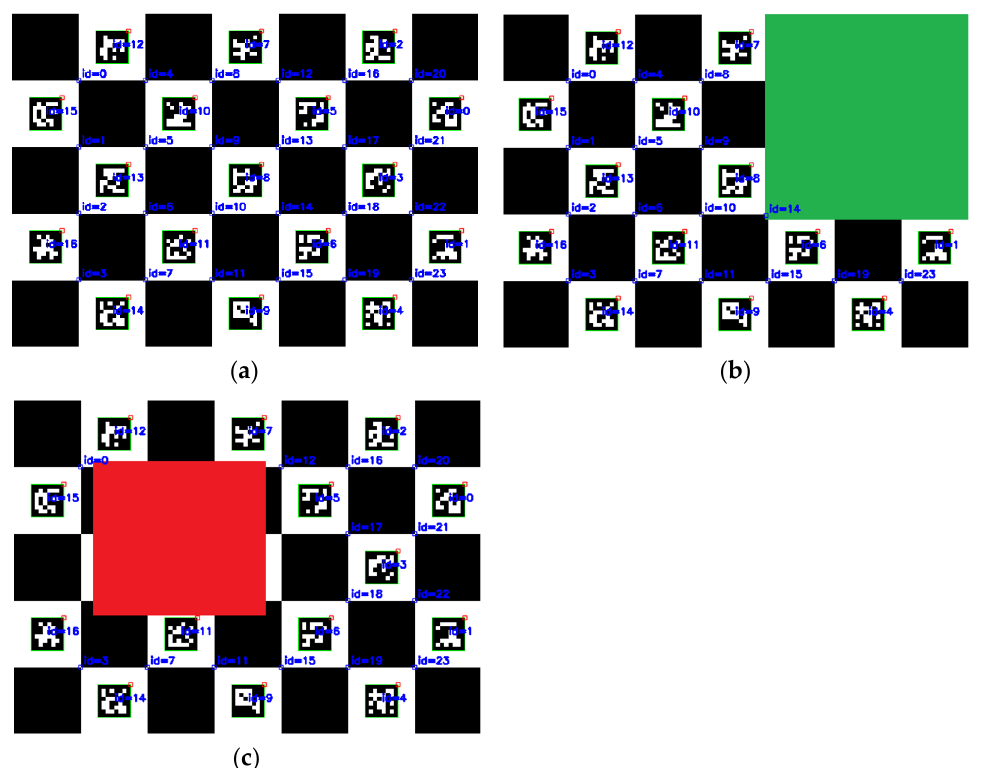
Figure 3. ChArUco board corner detection under different circumstances: ( a ) Corner detection under normal circumstances; ( b ) Corner detection when corners are occluded; and ( c ) Corner detection with intermediate occlusion.